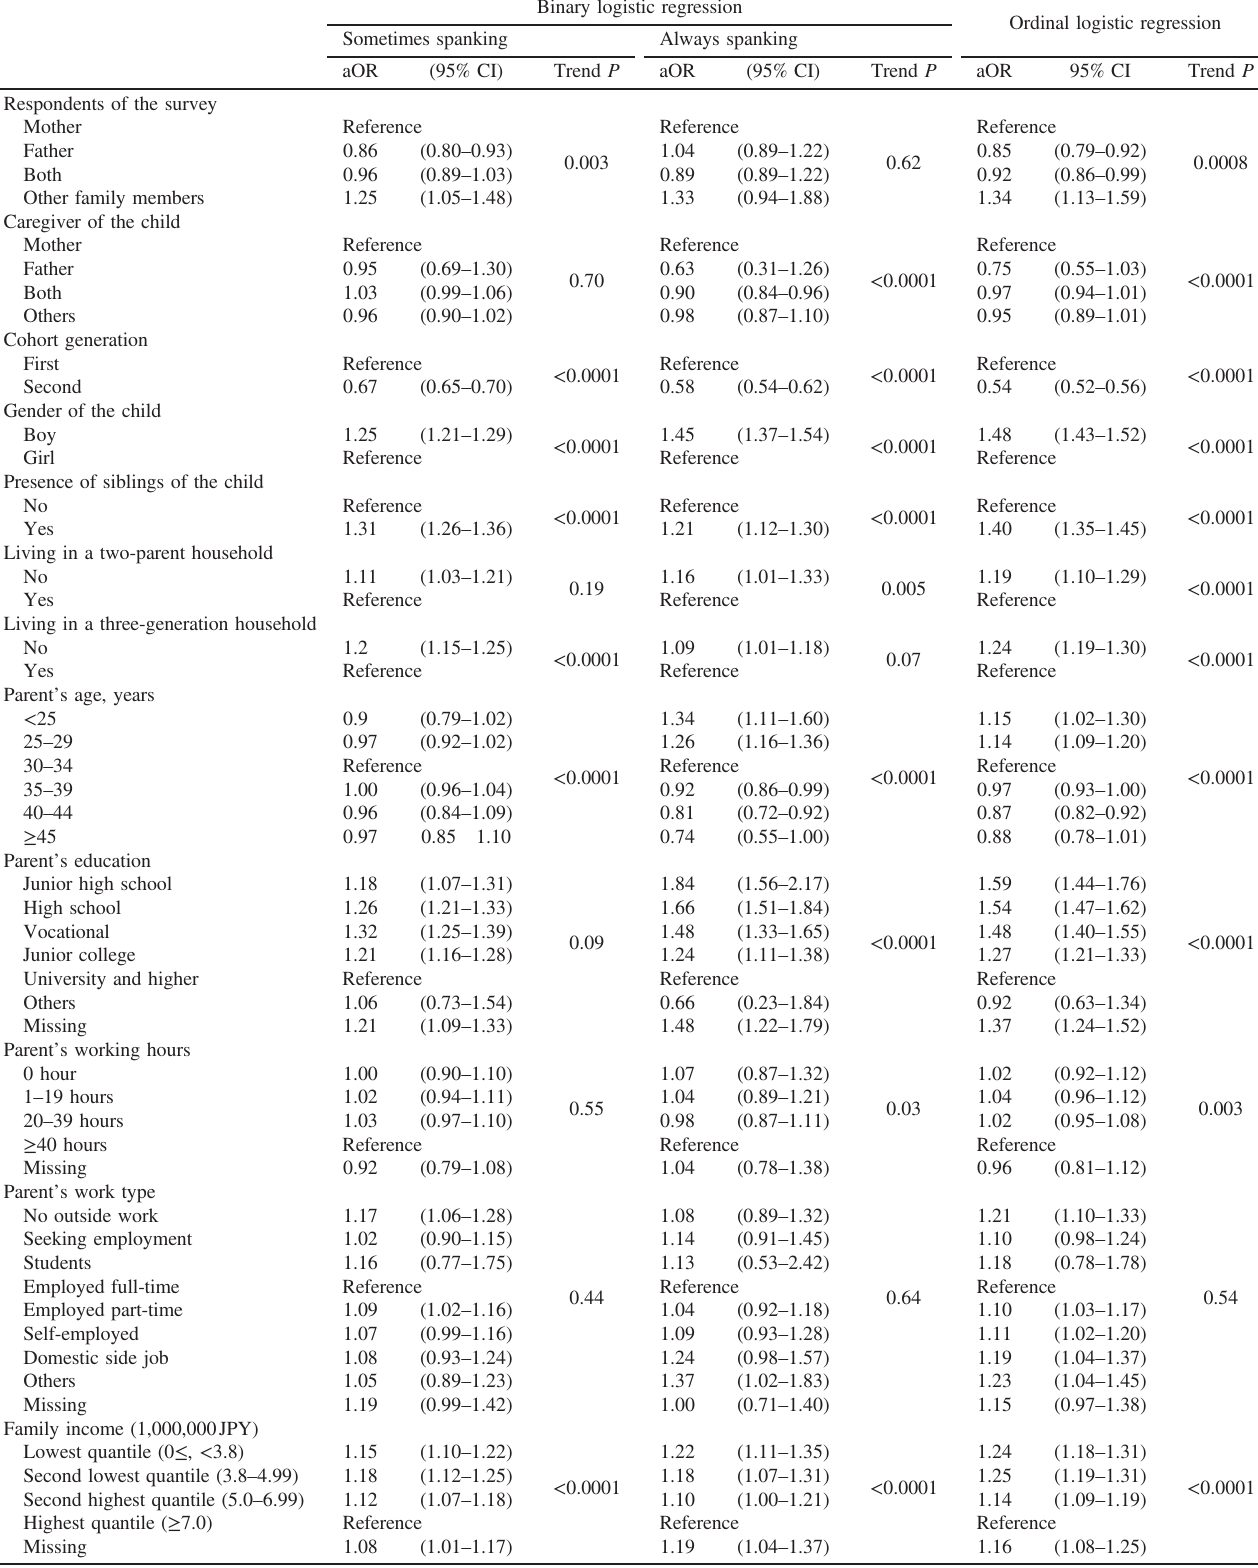
Ordinal logistic regression